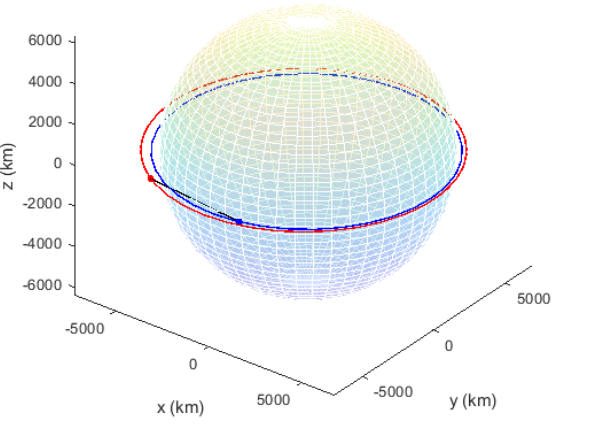
Table 1. Orbital elements of S and D and results.